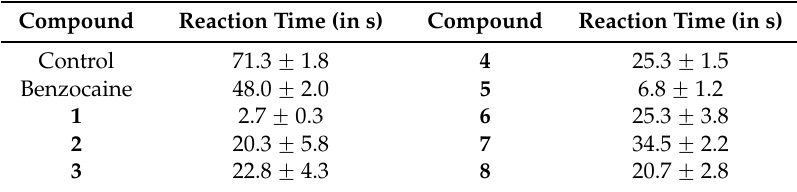
Table 1. Analgesic activity of compounds 1 – 8 in the AITC test in mice (2% w / w